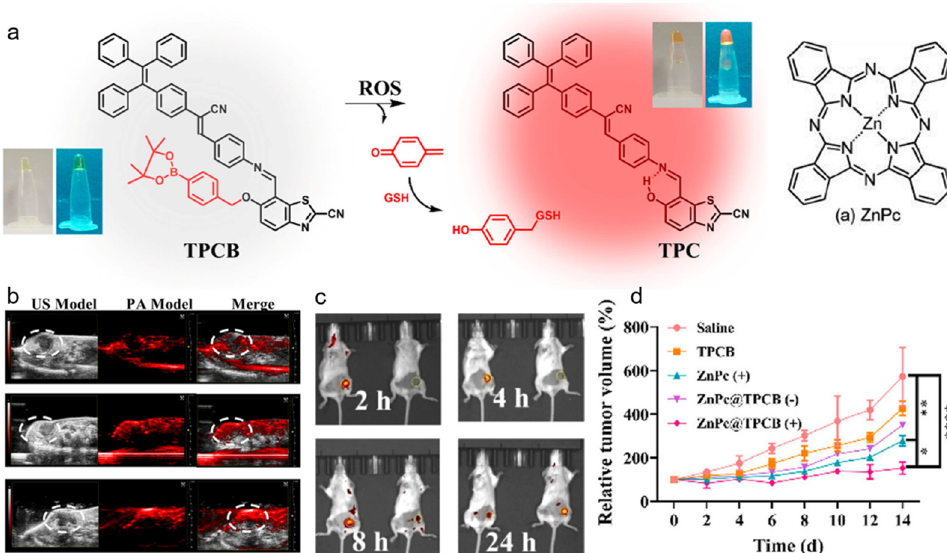
Figure 5. ( a ) Chemical structure and the ROS-activatable process of TPCB probe; ( b ) in vivo ultrasound and PA and ( c ) fluorescence imaging of 4T1 tumor-bearing mice after injecting the nanoprobe; ( d ) tumor growth curves of 4T1 tumor-bearing mice with different treatments. * p < 0.05, ** p < 0.01, **** p < 0.001. (Reproduced with the permission from ref. [120]. Copyright 2021, American Chemical Society).